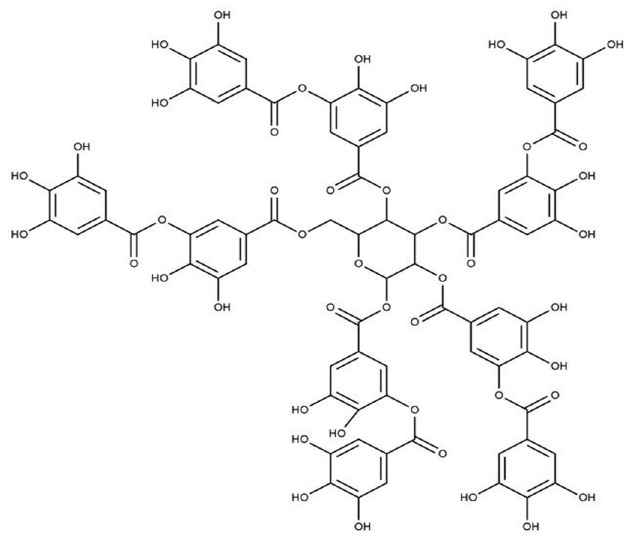
Figure 7. Structure of Tannic acid.